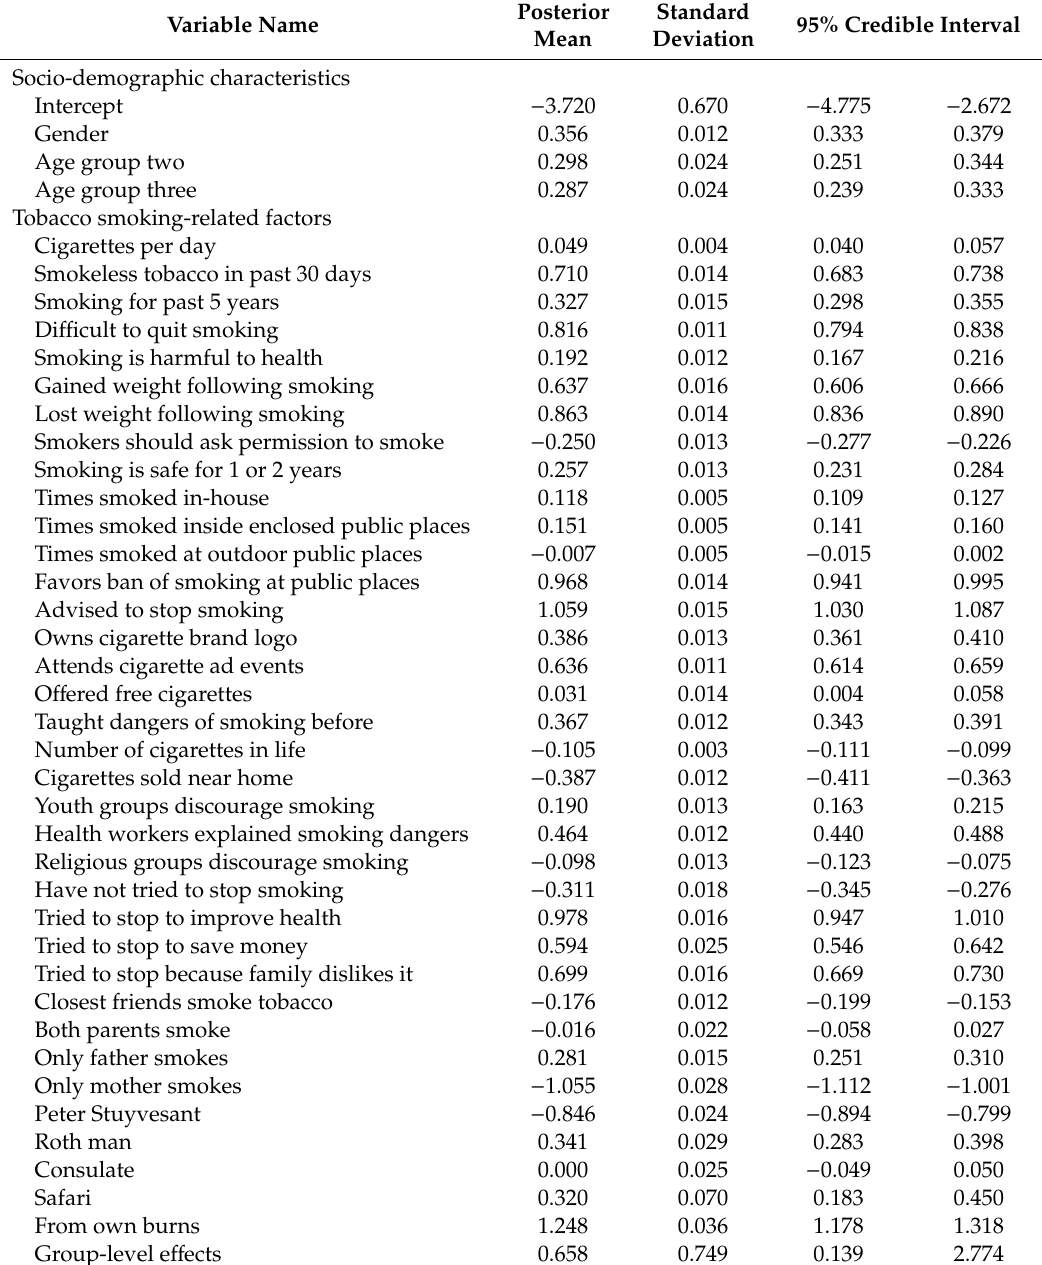
Table A1. Posterior means, standard deviations, and Bayesian 95% credible